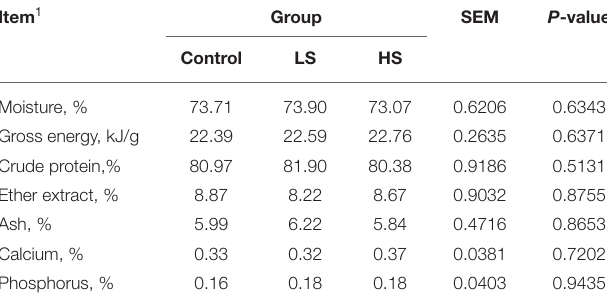
TABLE 4 | Effect of selenium-yeast on muscle chemical composition of goats.